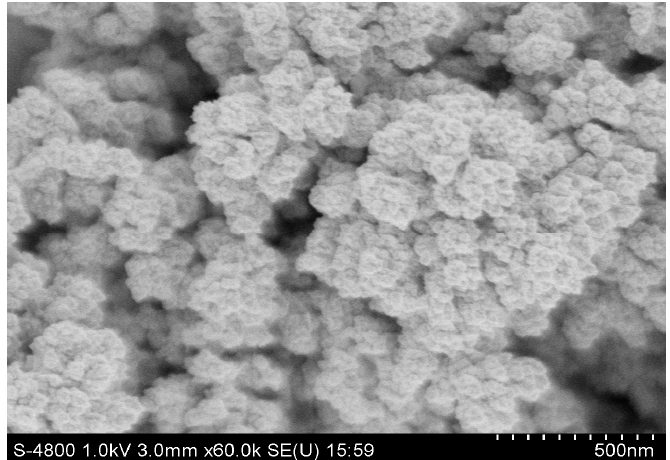
Figure 2. The SEM image ( × 60K) of the metal Pd.